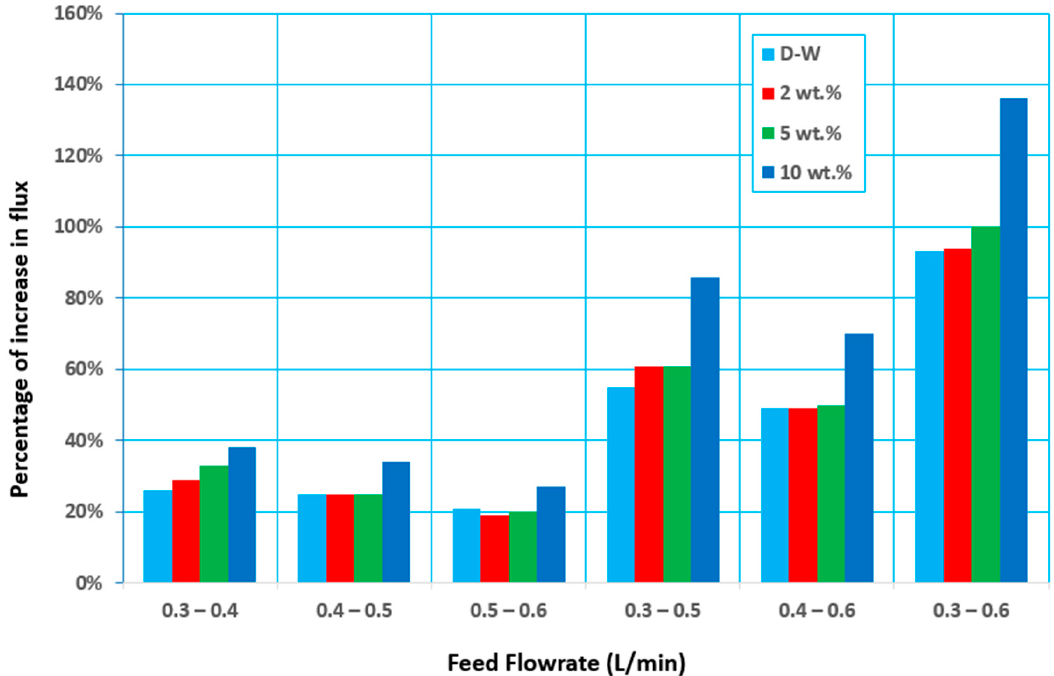
Figure 6. Percentage increase in flux with an increasing feed flow rate at different feed initial concentrations and at 30 °C and 60 mmHg (abs) pressure.